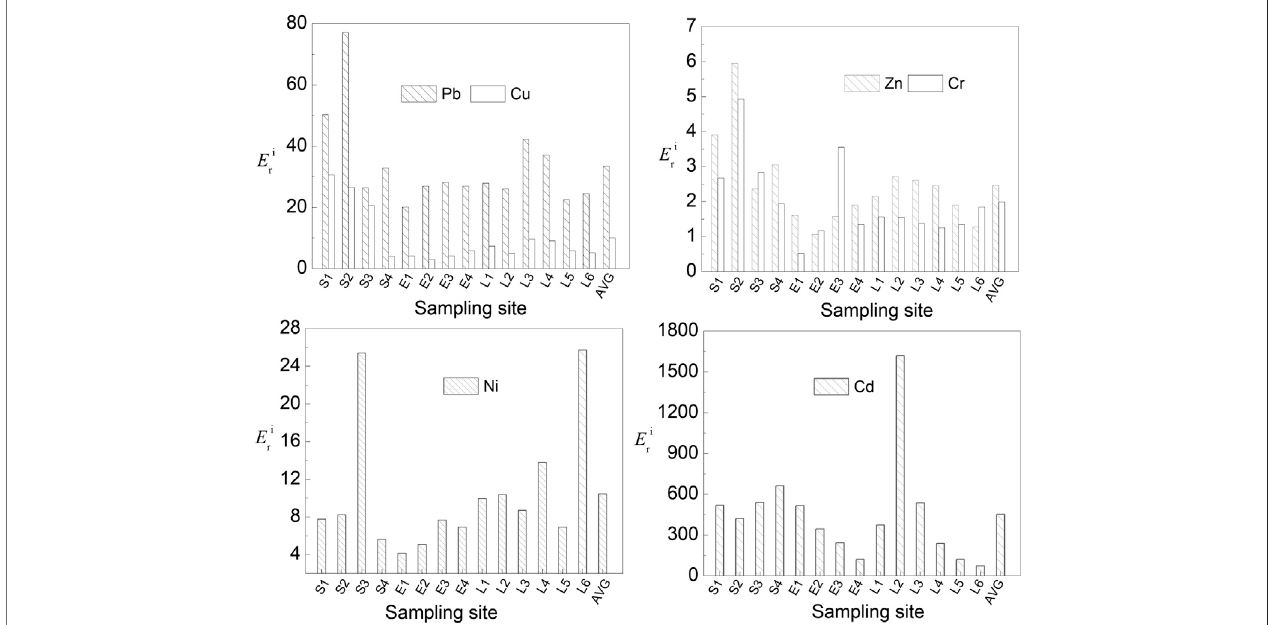
FIGURE 4 | Distribution of the E ri of various heavy metals in the surface sediments of wetlands.